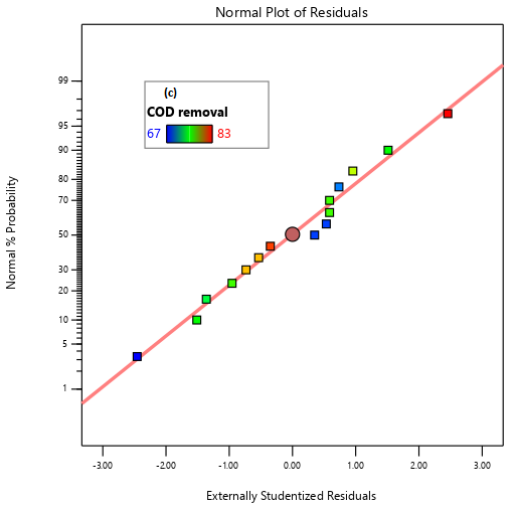
Figure 6. Normality plot of ( a ) CIP, ( b ) ENRO, and ( c ) COD removal. The response removal was graphically shown through three-dimensional (3D) plots. The effect of pH (A) and OLR (B) on CIP, ENRO, and COD removal in relating to their respective model Equations (4)–(6) are presented in Figure 7.